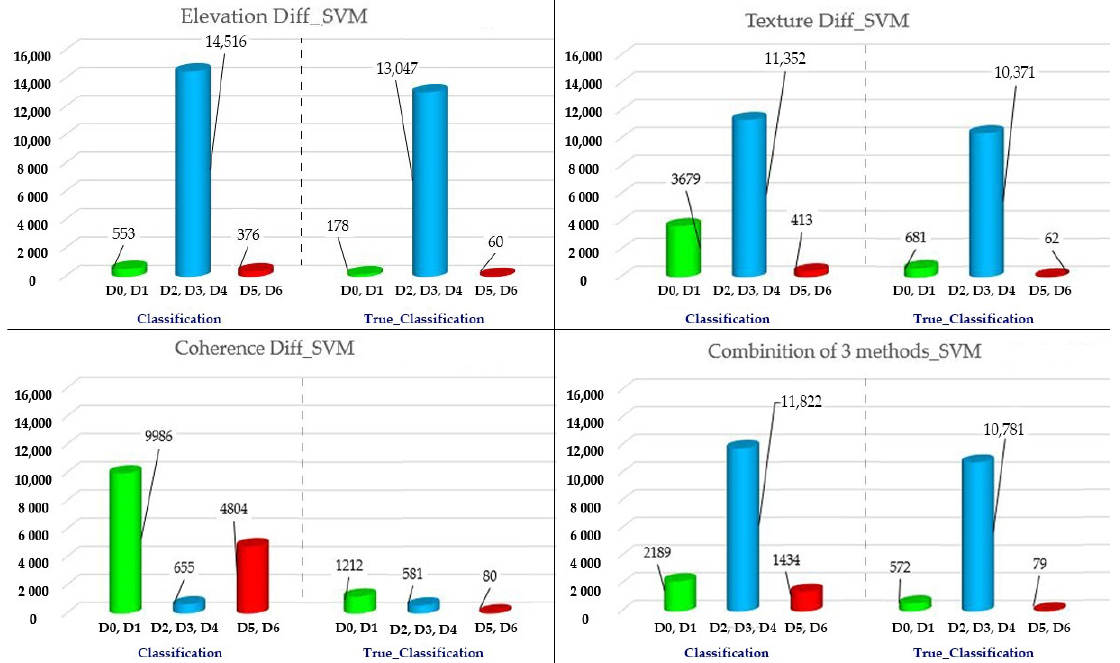
Figure 12. Estimated results, of the SVM algorithm by considering 4 methods (3DR).